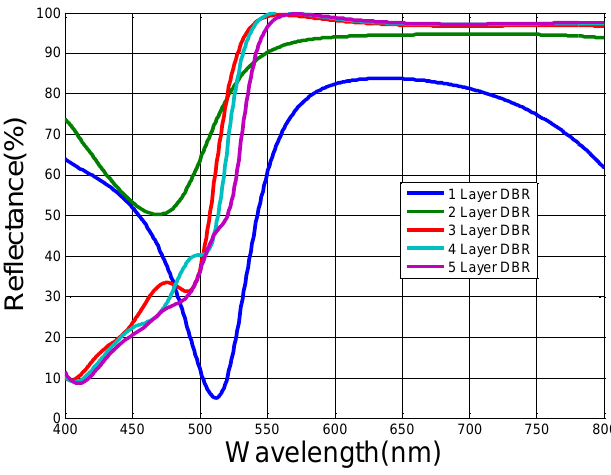
Figure 4. Reflectance characteristics for DBR’s with a varying number of layers, the label “1 Layer” is used to denote a DBR with one period, “2 Layer” for a DBR with two periods, and so forth.